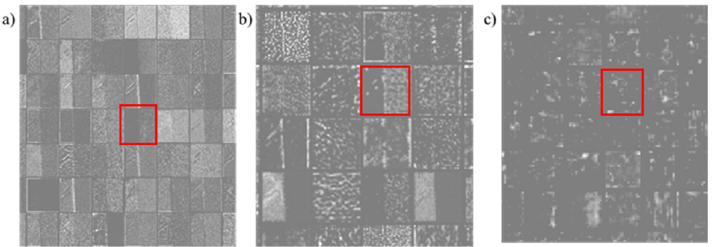
Figure 4. The changing process of feature-map transmission in neural networks. For the convenience of display, the feature maps of multiple channels at each stage are drawn in the form of grayscale images and spliced together. ( a – c ) represent the feature maps generated by Stage 1-Stage 3 of ResNet50, respectively.